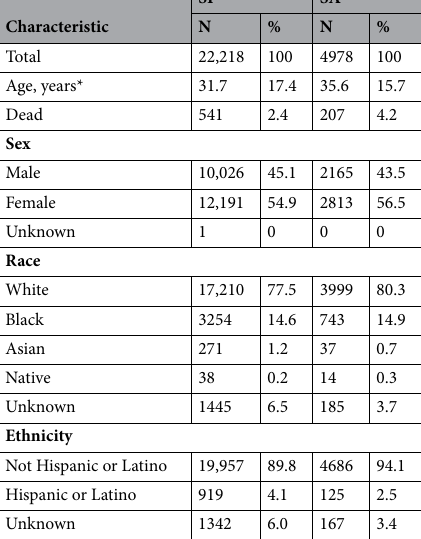
Table 5. Characteristics of suicidal ideation (SI) and suicide attempt (SA) cases identified in the EHR with a precision of at least 90%. *Reported as mean and standard